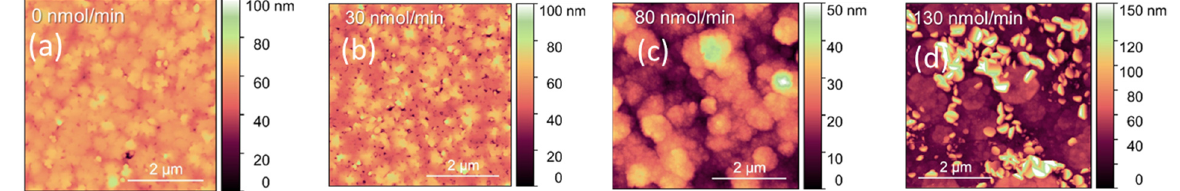
Figure 3. InAlN layers AFM analysis for Cp 2 Mg flow of ( a ) 0 nmol/min, ( b ) 30 nmol/min, ( c ) 80 nmol/min, and ( d ) 130 nmol/min.